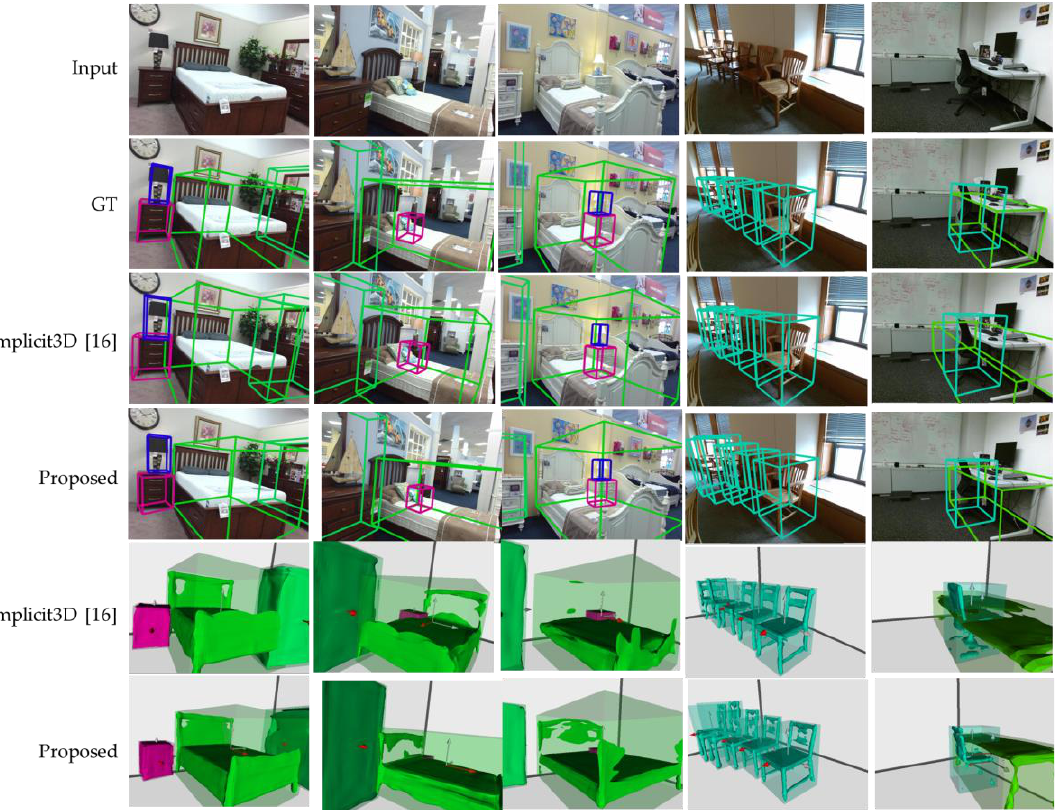
Figure 5. Detection and reconstruction results of various methods on the SUN RGB-D dataset [18]. The top row shows the input image. The second to fourth rows display the 3D bounding boxes obtained from ground truth, Implicit3D [16], and the proposed method. The fifth and sixth rows show the reconstructed 3D scenes using Implicit3D [16] and the proposed method, respectively.